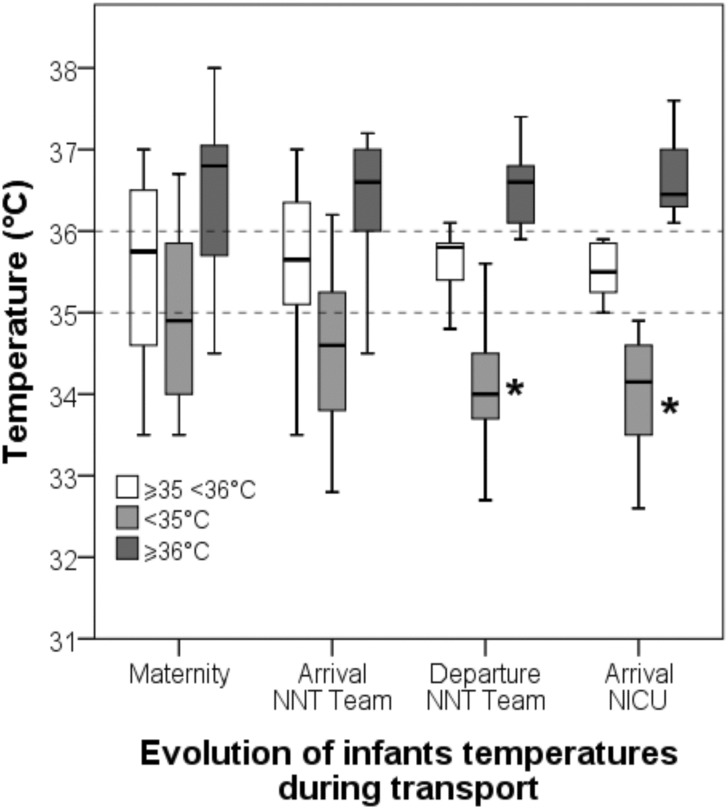
The temperature variation during transport in the three sub-groups according to temperature on arrival in Neonatal Intensive Care (≥35-<36°C [n = 41, reference], <35°C [n = 40°, ≥36°C [n = 39]).